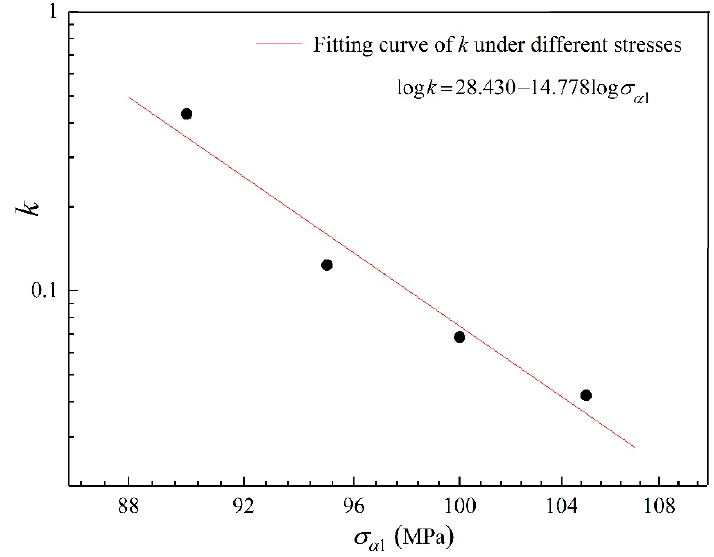
Figure 11. Fatigue damage of designed T-type specimens under different high cyclic stresses.